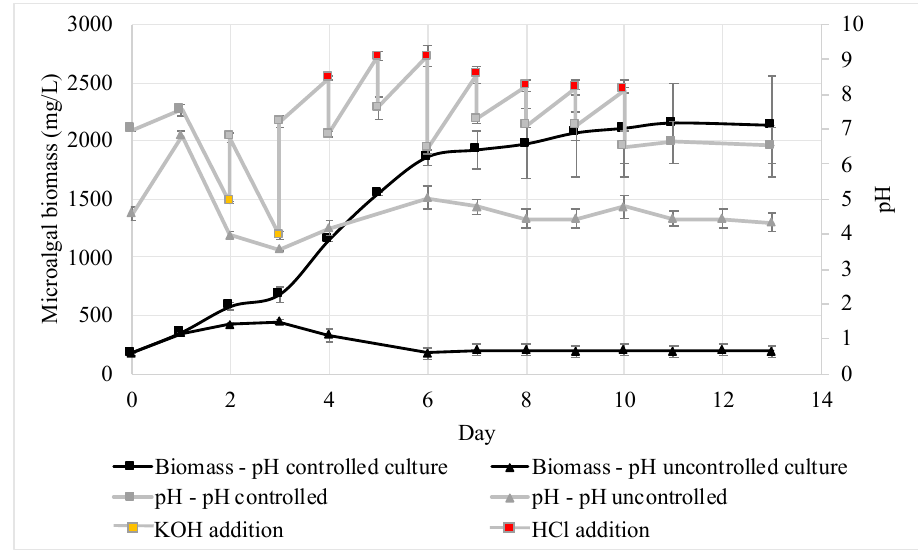
Figure 2. pH measurements and biomass growth curves, with standard deviations, of two cultures of C. sorokiniana cultivated in AWW. In black, the biomass concentration, and in gray, the pH values. The boxes represent the pH-controlled culture, and the triangles, the pH-uncontrolled culture. Orange boxes indicate the pH values before the KOH addition. Red boxes indicate the pH value before HCl addition. Number of samples per treatment = 3.